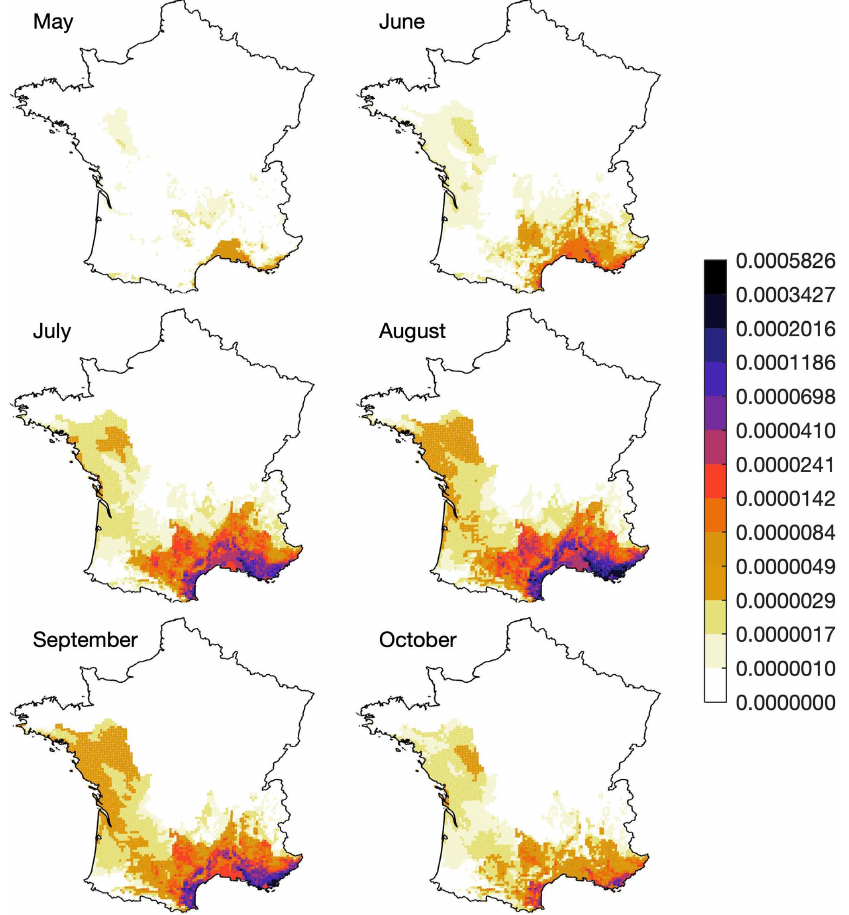
Figure 5. Daily large-wildfire ( > 100ha) probabilities across months averaged from 2001 to 2016. Note the highly nonlinear color bar (probabilities in the highest class are > 582 times higher than those in the first